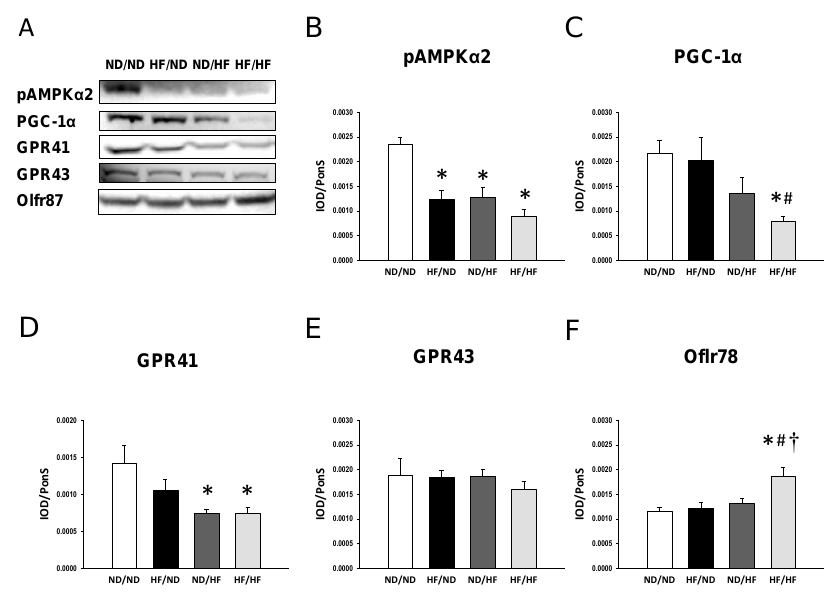
Figure 2. ( A ) Representative western blots showing phosphorylated AMP-activated protein kinase (AMPK α 2, ~63kDa), peroxisome proliferator-activated receptor co-activator 1 α (PGC-1 α , ~90kDa), G protein-coupled receptor 41 (GPR41, ~38kDa), GPR43 (~47kDa), and olfactory receptor 78 (Oflr78) (~35kDa) bands in o ff spring kidneys at 16 weeks of age. Relative abundance of renal cortical ( B ) phosphorylated AMPK α 2, ( C ) PGC-1 α , ( D ) GPR41, ( E ) GPR43, and ( F ) Oflr78 were quantified. ND / ND, maternal plus post-weaning normal diet; HF / ND, maternal high-fat diet plus post-weaning normal diet; ND / HF, maternal normal diet plus post-weaning high-fat diet; HF / HF, maternal plus post-weaning high-fat diet. n = 8 / group. * p < 0.05 vs. ND / ND; # p < 0.05 vs. HF / ND; † p < 0.05 vs. ND / HF.